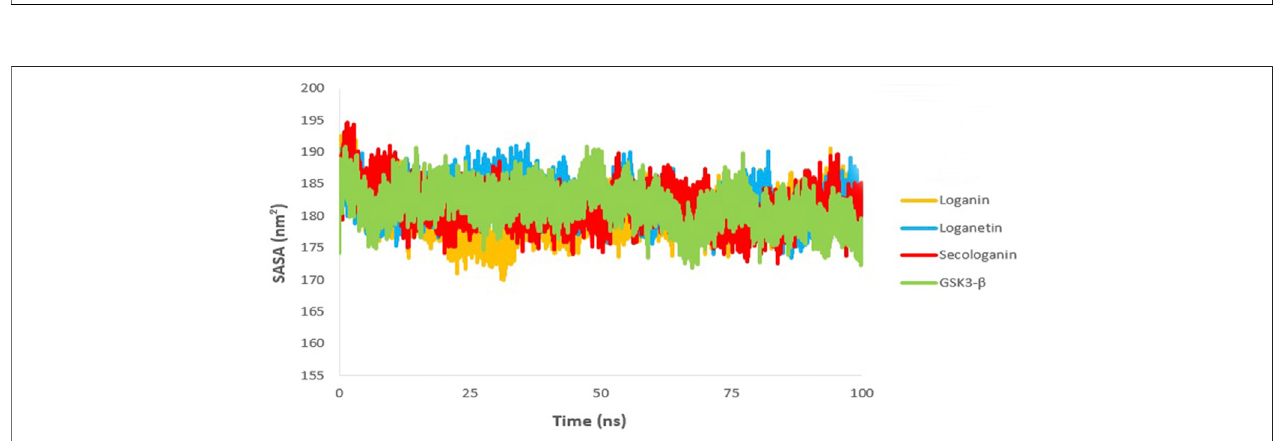
FIGURE 11 | SASA analysis GSK3- β protein (green), loganin-GSK3- β complex (yellow), loganetin-GSK3- β complex (blue), and secologanin-GSK3- β complex (red).